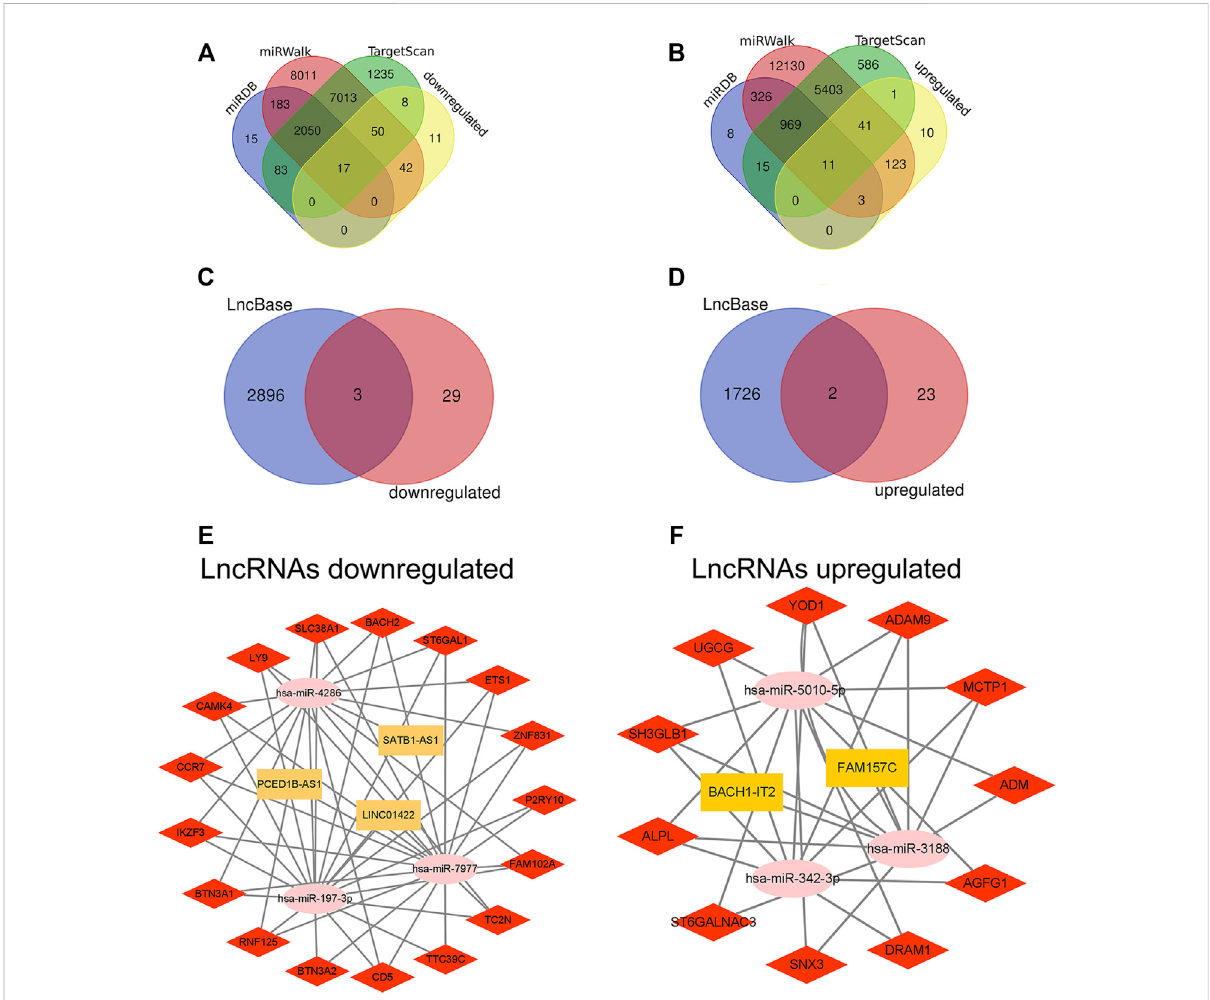
FIGURE 7 Construction of ceRNA network in sepsis. (A,B) Venn diagram showing the number of distinct and overlapping mRNAs among the downregulated and upregulated DEmRNAs, and the mRNAs identi fi ed with miRDB, miRWalk, and TargetScan. The overlapping areas show the downregulated and upregulated mRNAs identi fi ed by three online tools. (C,D) Venn diagram showing the number of distinct and overlapping lncRNAs among the downregulated and upregulated DElncRNAs, and the lncRNAs identi fi ed with LncBase. The overlapping areas show the downregulatedandupregulatedlncRNAsidenti fi edbyLncbaseonlinetool. (E,F) ConstructionofacompletelncRNA-miRNA-mRNAceRNAnetwork according to the upregulation and downregulation of lncRNAs. The yellow rectangles represent DElncRNAs, the pink ellipses represent DEmiRNA, and the red diamonds represent DEmRNAs. DElncRNAs, differentially expressed lncRNAs; DEmiRNAs, differentially expressed miRNAs; DEmRNAs, differentially expressed